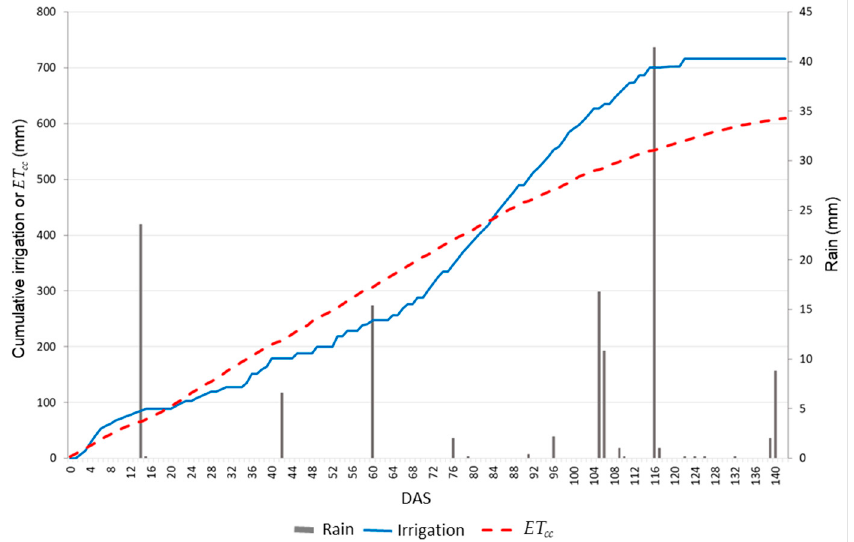
Figure 3. Crop irrigation and cumulative evapotranspiration ( ET cc ) throughout the irrigation campaign and precipitation events.